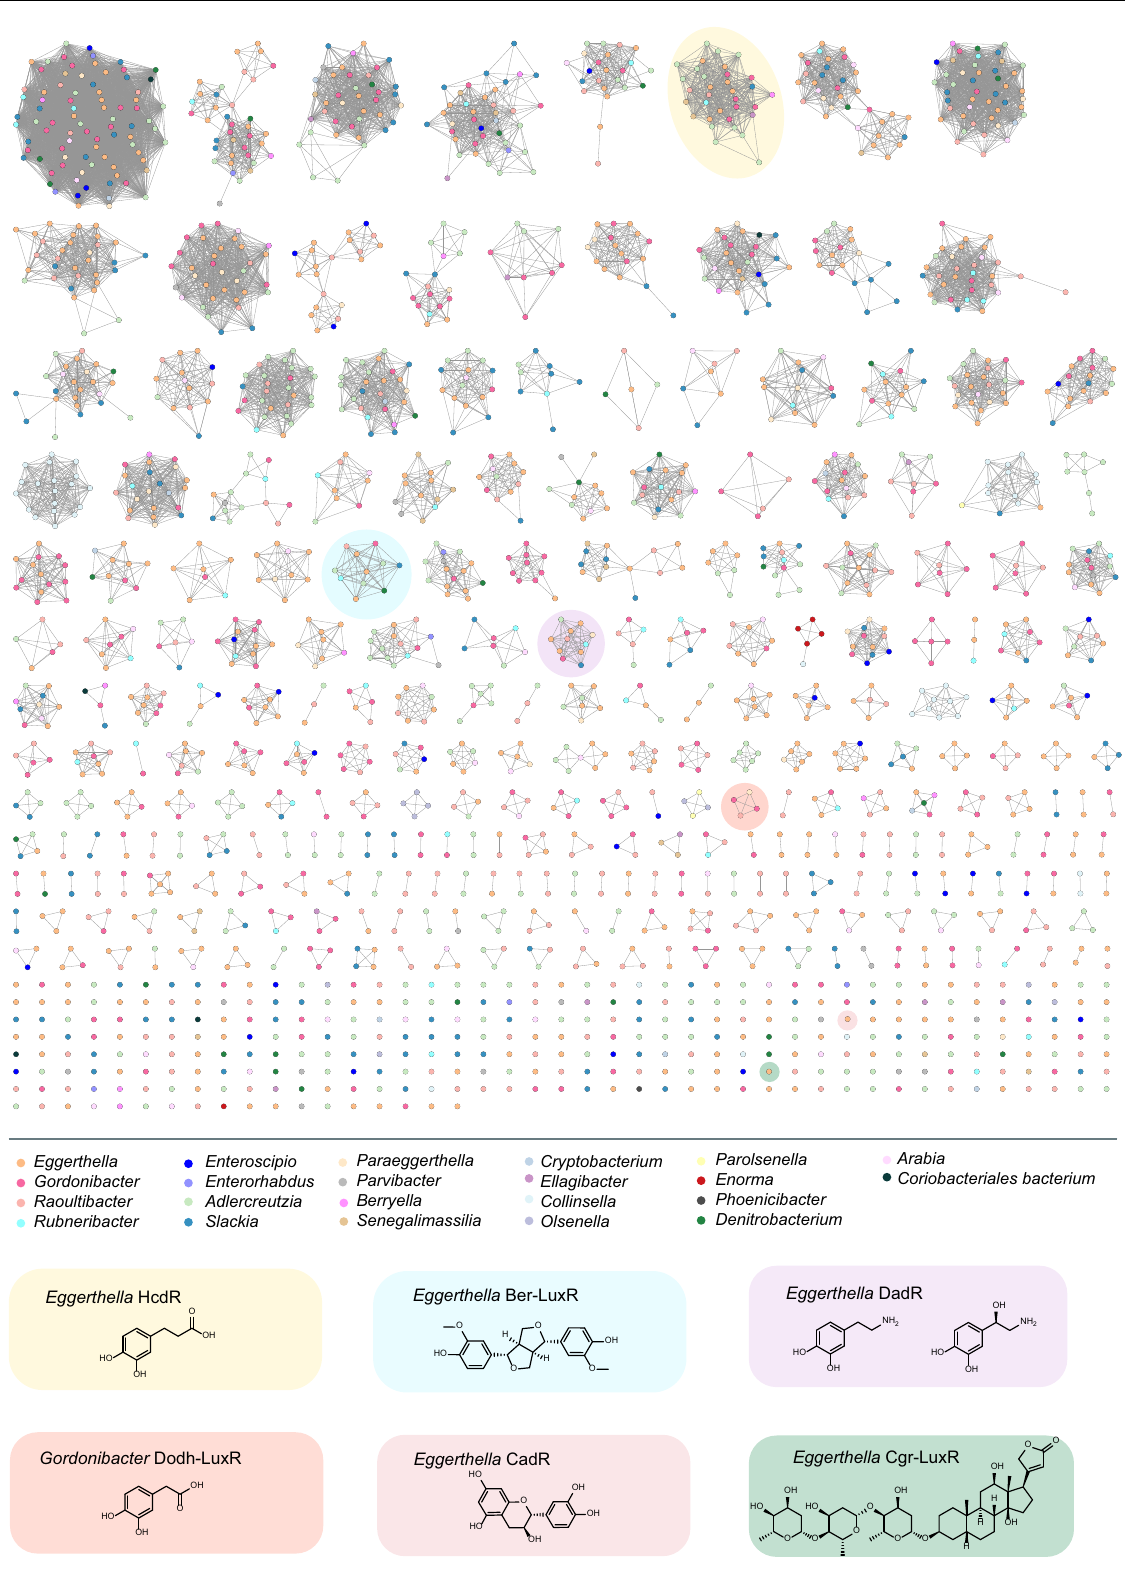
Fig. 7 | Sequence similarity network of Coriobacteriia 10 – 12-TM LuxR reg- ulatorsrevealshighdiversityoftheseregulators. TheSSNwasconstructedusing Coriobacteriia protein sequences from IMG/M database containing a pfam00196 domain (Bacterial regulatory proteins, LuxR family) and predicted to have 10 – 12 N-terminal TM helices. Nodes represent proteins with 95% sequence identity.